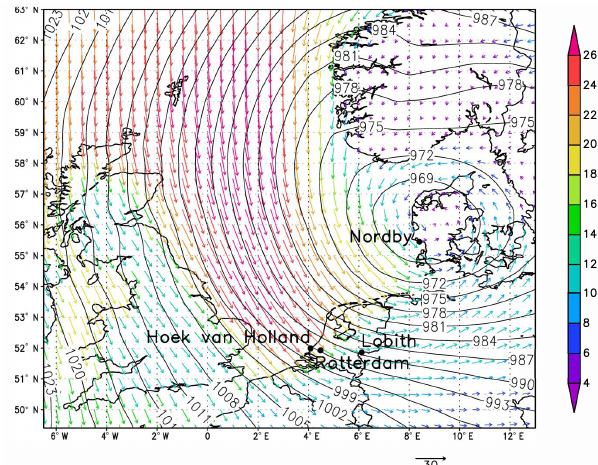
Figure 4. Wind and pressure fields for the situation leading to the highest surge in Hoek van Holland that occurred in the ECMWF- WAQUA/DCSMv5 ensemble. The locations of Hoek van Holland, Rotterdam, Lobith and Nordby are indicated.